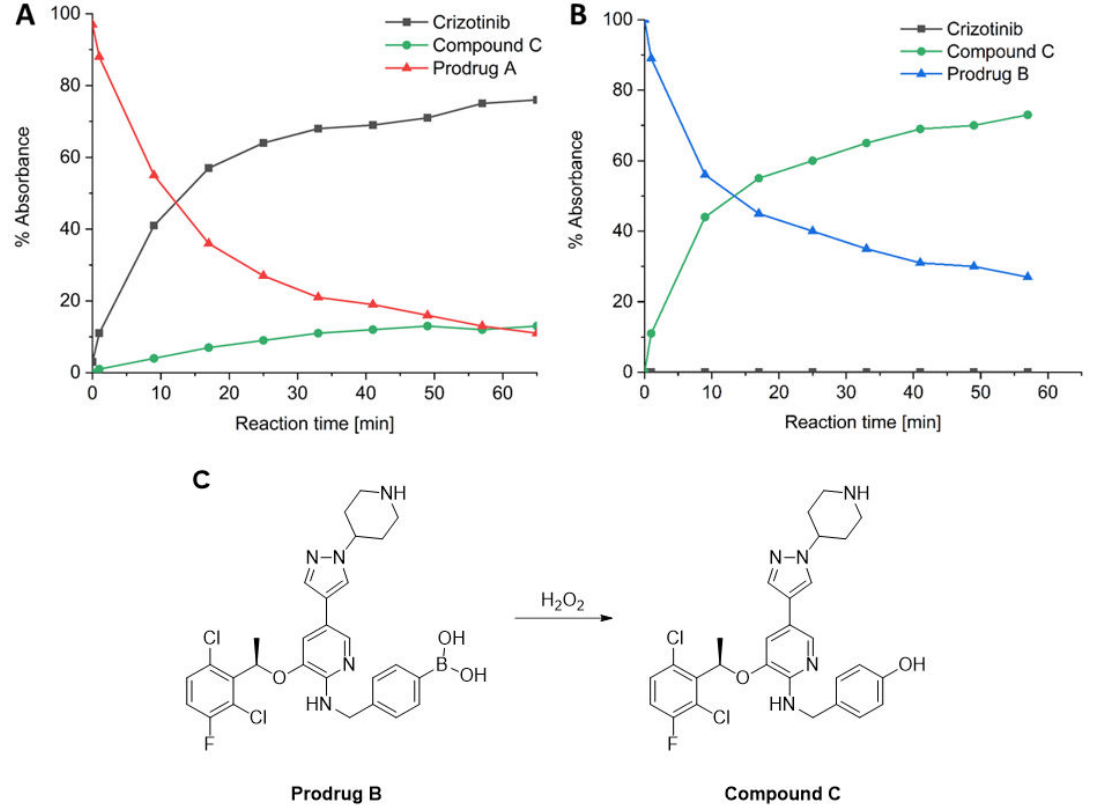
Figure 3. ( A , B ) Activation of prodrug A and prodrug B in phosphate bu ff er (50 mM) at pH 7.4 and 37 ◦ C for 1 h in the presence of ten equivalents of H 2 O 2 . In the case of prodrug A , after 10 min, ~50% of crizotinib was released. ( C ) In the case of prodrug B , the activation led to the formation of compound C rather than the release of